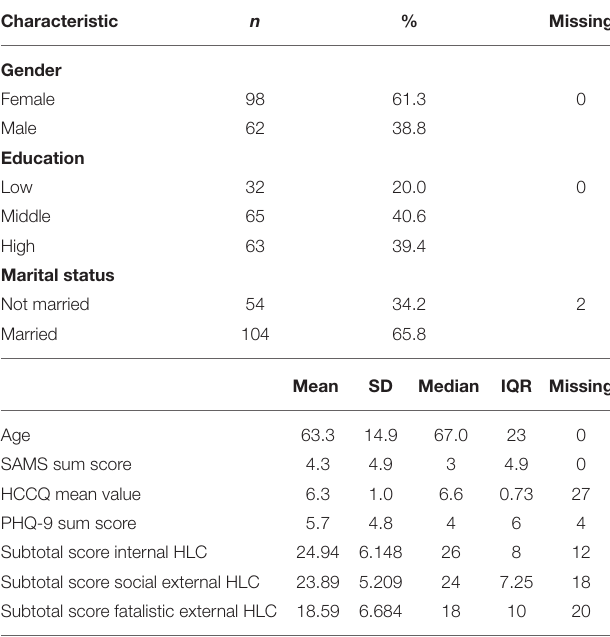
TABLE 1 | Characteristics of the